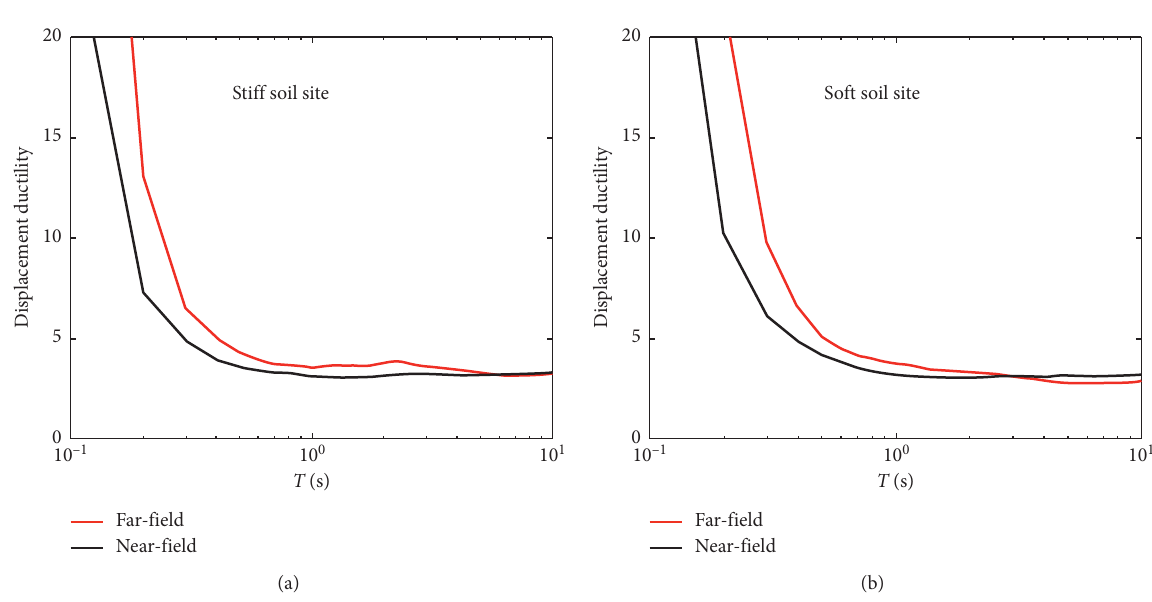
Figure 10: Effect of epicentre distance on the variation of mean constant-strength ductility spectra: (a) stiff soil site; (b) soft soil